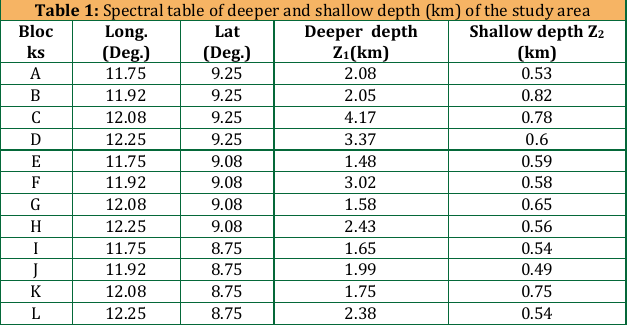
Figure 7: Source Parameter Imaging (SPI) Map of the Study